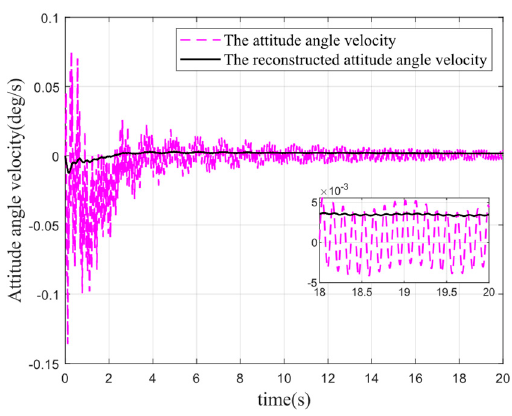
Figure 12. Attitude angular rate reconstruction with external interference.